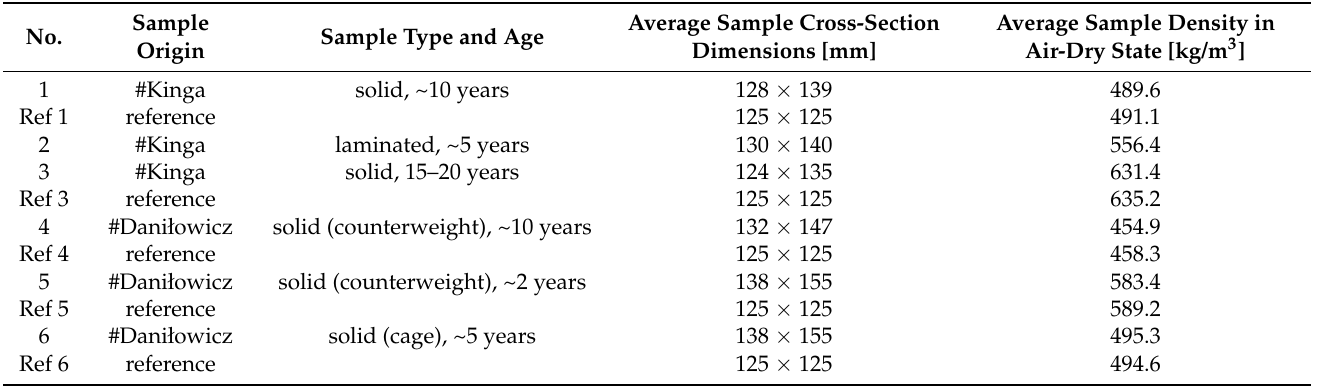
Table 2. Parameters of the test